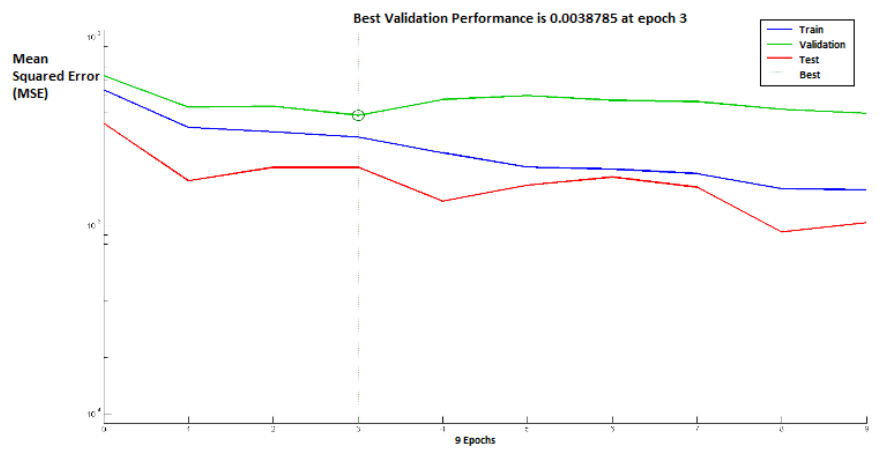
Figure 8. Performance diagrams of the Polak–Ribiere neural network over nine epochs (blue: learning/ green: validation).